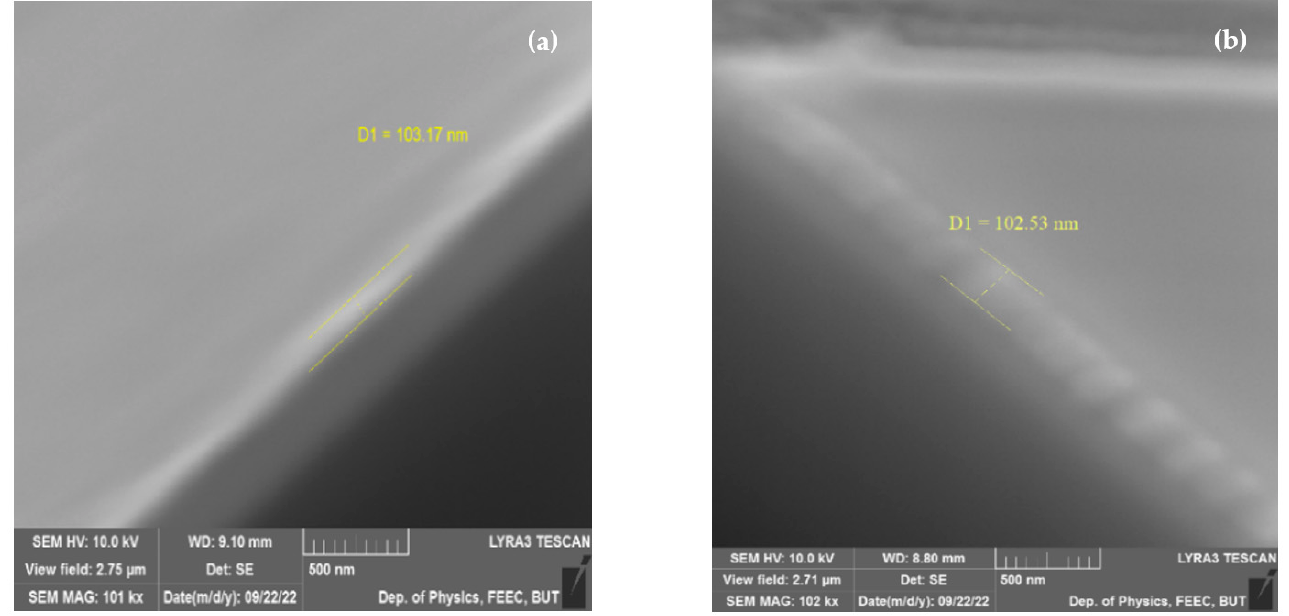
Figure 1. Cross section of 100 nm thick BFO samples ( a ) on Pt/TiO 2 /Si substrate ( b ) on Pt/Ti/Si substrate.